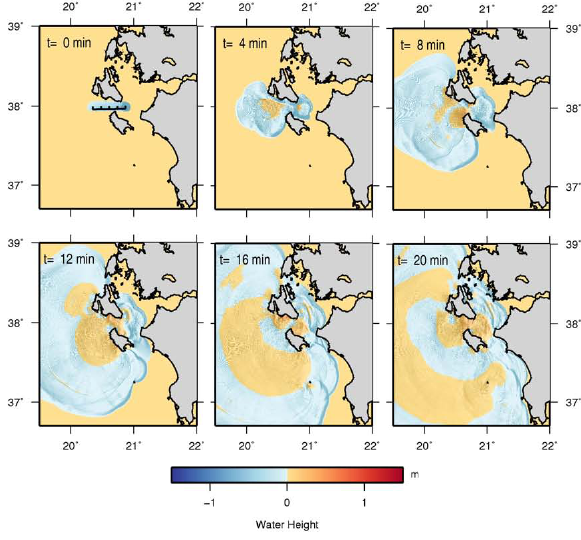
Fig. 6. Snapshots of the tsunami propagation from the source 2 (Zakynthos fault) at 4-min intervals.